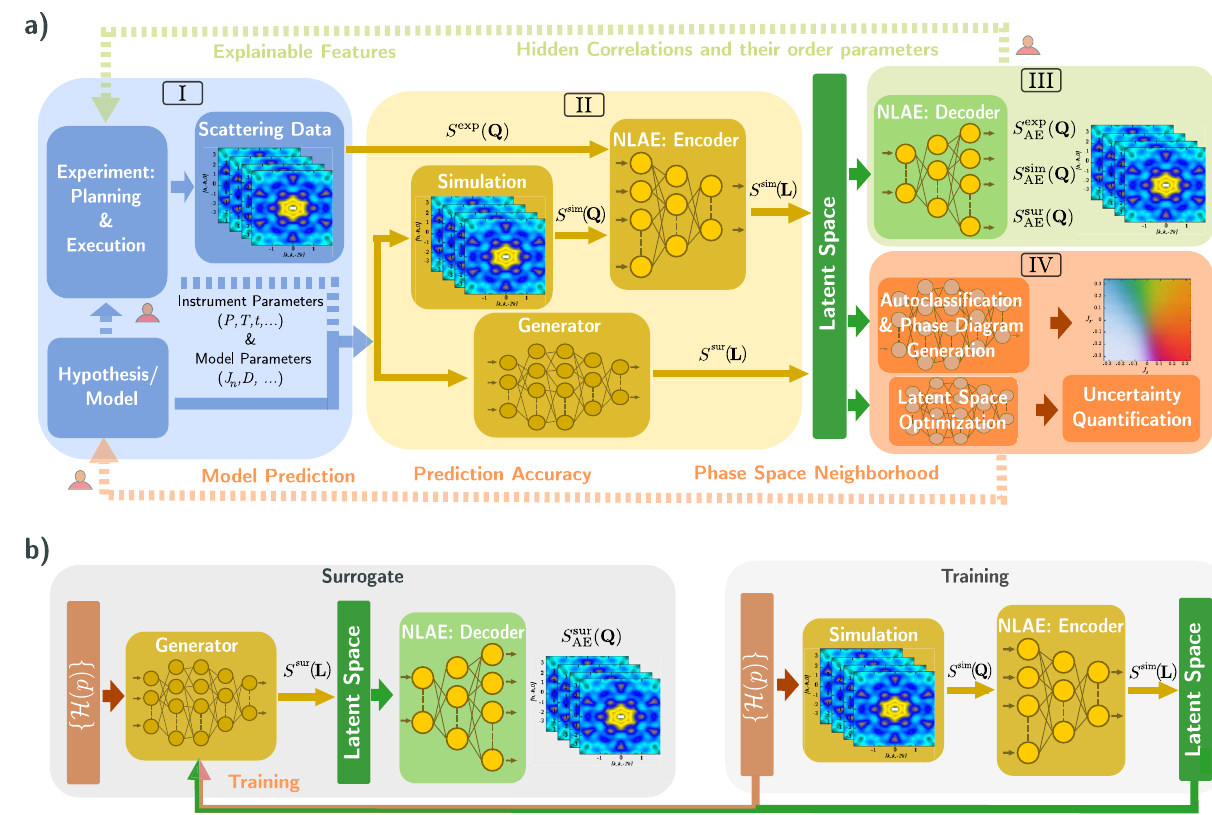
Fig. 1 Schematic overview of machine-learning integration into the direct and inverse scattering problem. a The ML work fl ow used here to drive the scattering experiment with automated data analysis and feeding back vital information. The work fl ow is split into four main sections: (I) scattering experiment design and optimization; (II) parameter space exploration and information compression; (III) structure or property predictions; and (IV) parameter space predictions. Section II links to both III and IV via latent space, LS , a compressed version of the large pixel space. Dashed lines with a silhouette indicate parts of the fl ow that currently still require some human intervention. The latent space representations, S ( L ), are used in surrogates that bypass expensive calculations. b Schematic design of the surrogate model used to predict S ( L ) and S ( Q ) for a model with a given set of parameters, H ð p Þ . It comprises a radial basis network, mapping parameter space to latent space and a decoder to reconstruct S ( Q ) from latent space representations. The training of the surrogate is done based on a set of S ( L ) obtained from a set of models at different parameters, f H ð p Þg , using Monte Carlo simulations and NLAE encoding. These surrogates are used for exhaustive searches of parameter space, identifying phases and phase transitions, and predicting optimal regions for experimental study. More simulations are done iteratively in the areas of interest, and the surrogates are trained accordingly to improve their prediction